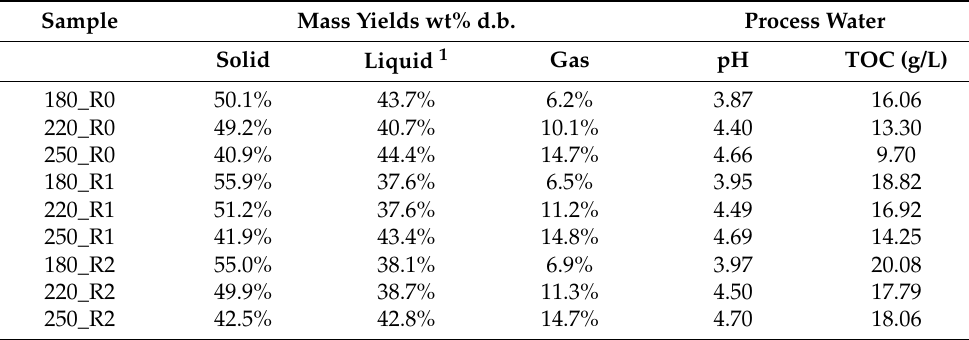
Table 1. Mass yields (dry basis) and process water characterization. Solid and gas fractions were measured after each HTC test performed in triplicate; average values showed (Er% ≤ 1.5% for solid yield and 2.3% for gas yield). Average values of three pH and TOC measurements showed (Er% ≤ 0.4% for pH and 0.5% for TOC). Sample Mass Yields wt% d.b. Process